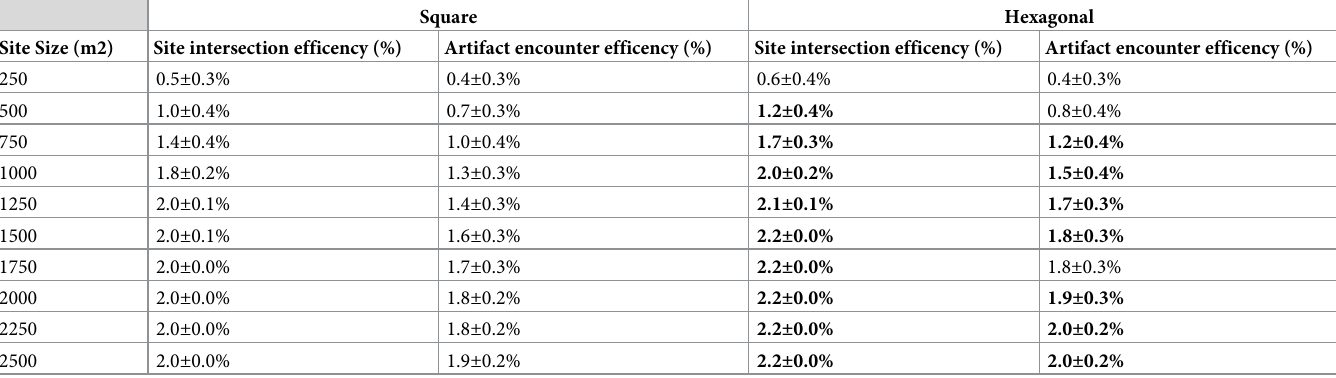
Table 4. Comparison of square and hexagonal grid